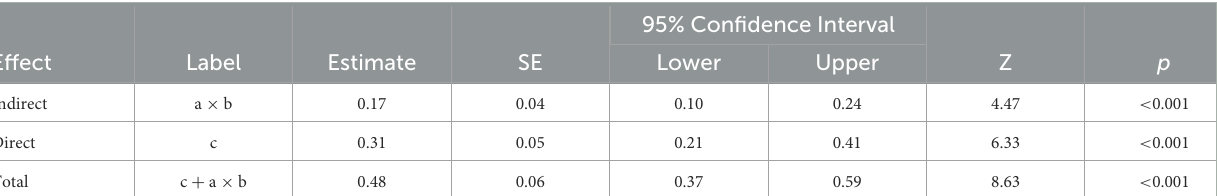
TABLE 7 Mediation estimates for the future